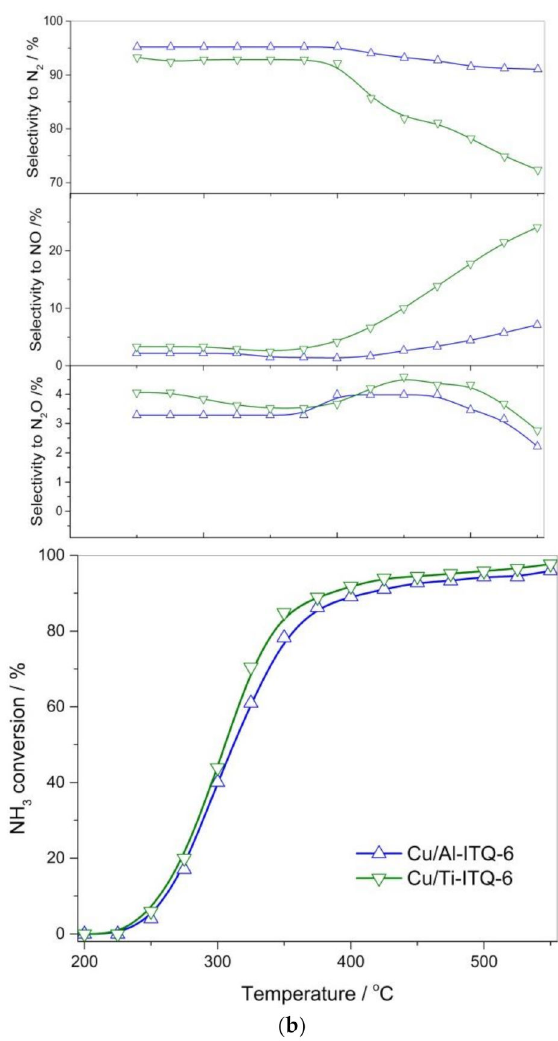
Figure 7. Results of NH 3 -SCO tests for ferrierite ( a ) and ITQ-6 ( b ) based